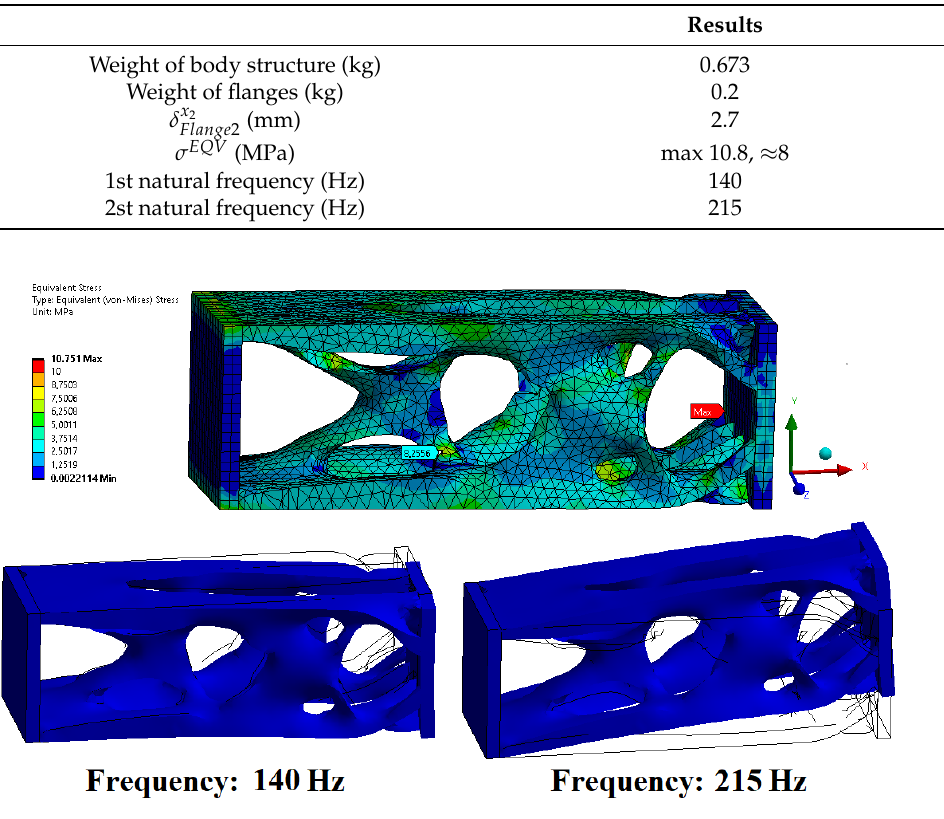
Figure 15. The resulting geometry after topological optimization, equivalent stresses and 2 natural